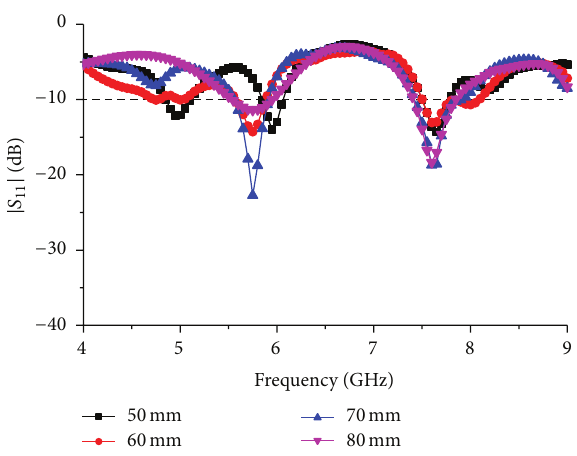
Figure6:Responsetotheparametricchangeingroundplanelength “ 𝑞